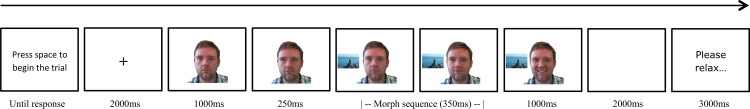
Example of a Learning Stage trial.Note that these scene and face images are not presented correctly to scale, in order to improve clarity; during the study the scene height was approximately 60% of the face height, please refer to the visual angle details in Stimuli and Presentation.